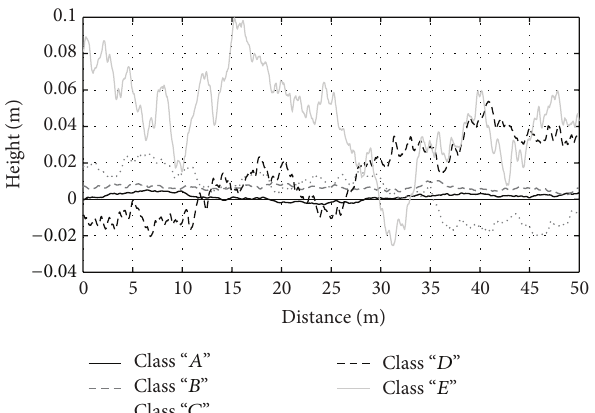
Figure 6: Example road profiles: Class “ 𝐴 ” to Class “ 𝐸 ” for a 50 m long